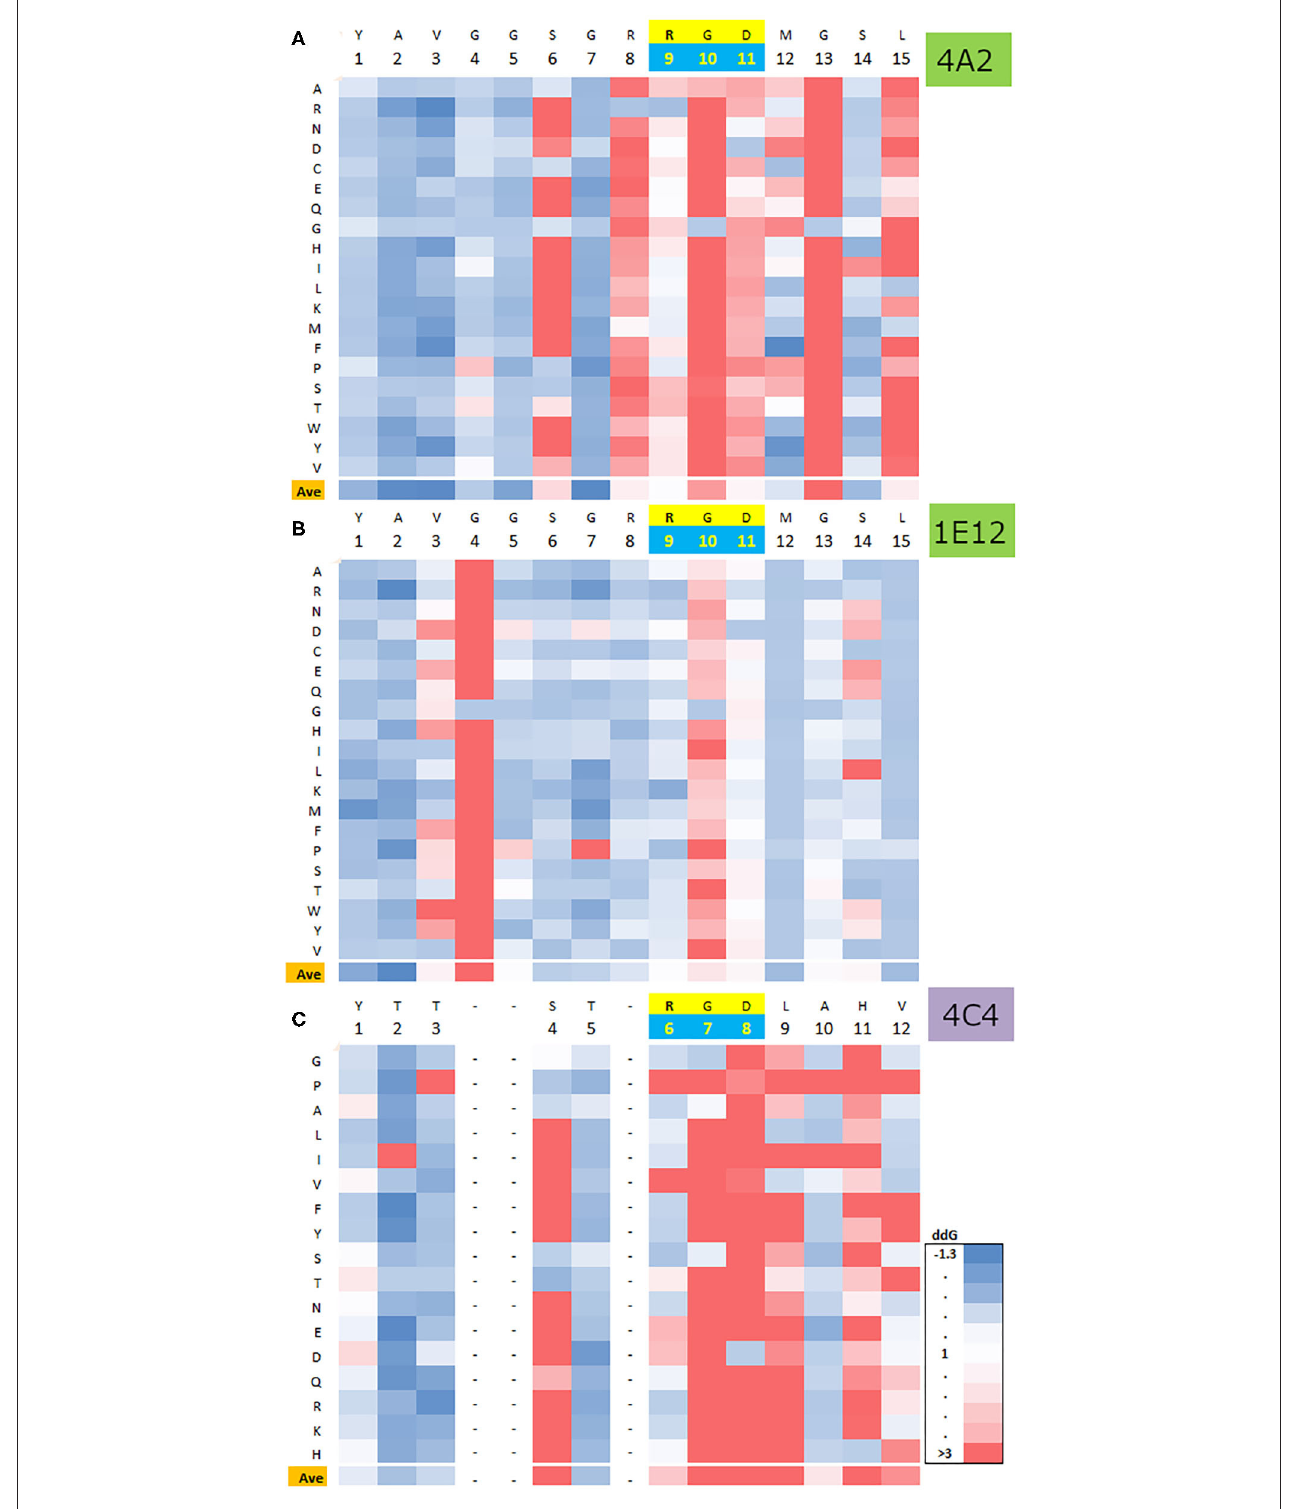
FIGURE 6 | AgSA mutational profile for three FMDV Ag–Ab complexes. Computational mining and comparison of the influence of single point mutations at the FMDV Ag partner for two Ag–Ab complexes and one Ag–Ab complex of reference. Horizontally, each panel contains the native FMDV AgSA sequence (see the conserved RGD motif in yellow) and, vertically, the energetic effect (dG) of single point aa mutations. (A,B) correspond to mAbs 4A2 and 1E12 interaction complexes, respectively, and (C) displays reference 4C4 mAb (pdb 1EJO) interaction data. Color variation from blue to red implies a worsening of the interaction energy and a less tolerated mutation at a given Ag–Ab. See the similarities between (A,C) involving IgG Abs and a different mutational profile for the IgM Ab (B) .